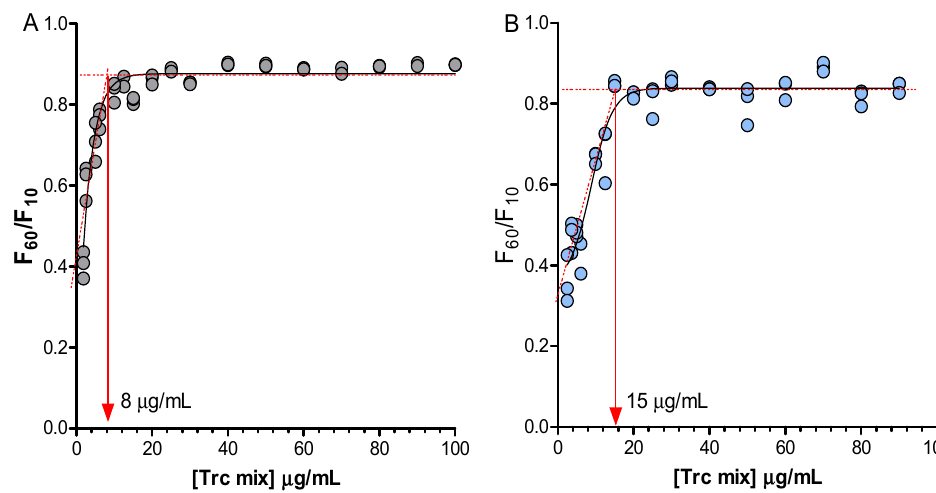
Figure 4. Monitoring the influence of the formulation on the oligomerisation concentration of the cyclodecapeptides in the Trc mix. Control ( A ); Trc mix: E4M (1:4) ( B ). Fluorescence excitation and emission of the Trc mix (1.25–100 µ g/mL) were at 280 and 348 nm, respectively. Three repeats of each preparation are shown via scatter dot plots. Continual readings were taken for the first 60 min with F60/F10 (the reading taken at 60 min/reading taken at 10 min). A sigmoidal curve with a variable slope was fitted to each of the data sets (R2 > 0.99) and the intercept between the slope and the plateau was taken as the critical oligomerisation concentration.